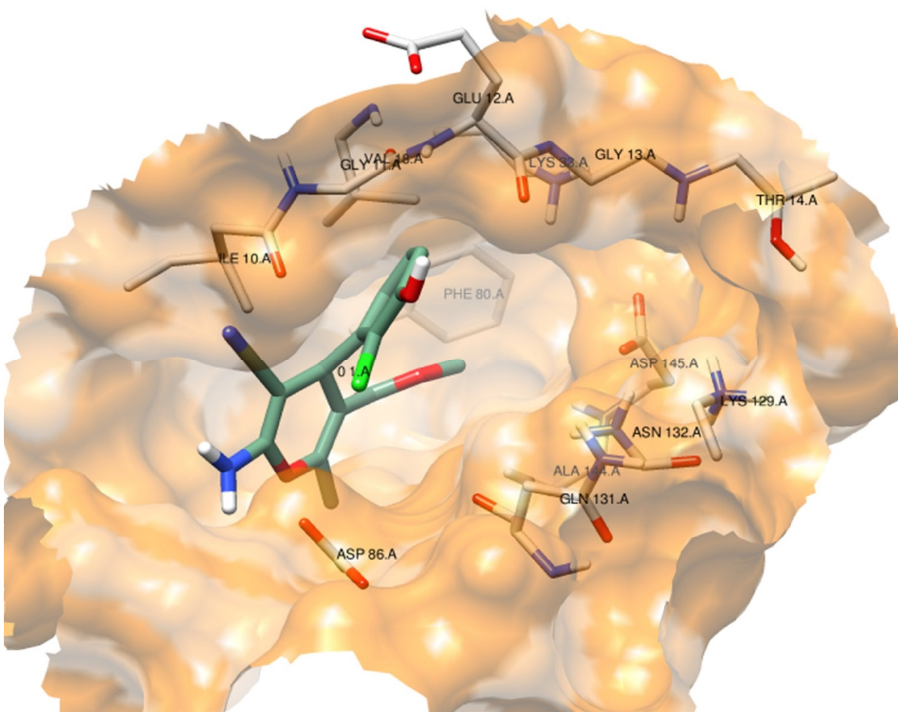
Figure 13. Three-dimensional model of binding interactions of compound 4f after docking calcula- tions in the ATP binding pocket of CDK2. Hydrogen atoms (white), nitrogen atoms (blue), chlorine atom (green), and oxygen atoms (red).